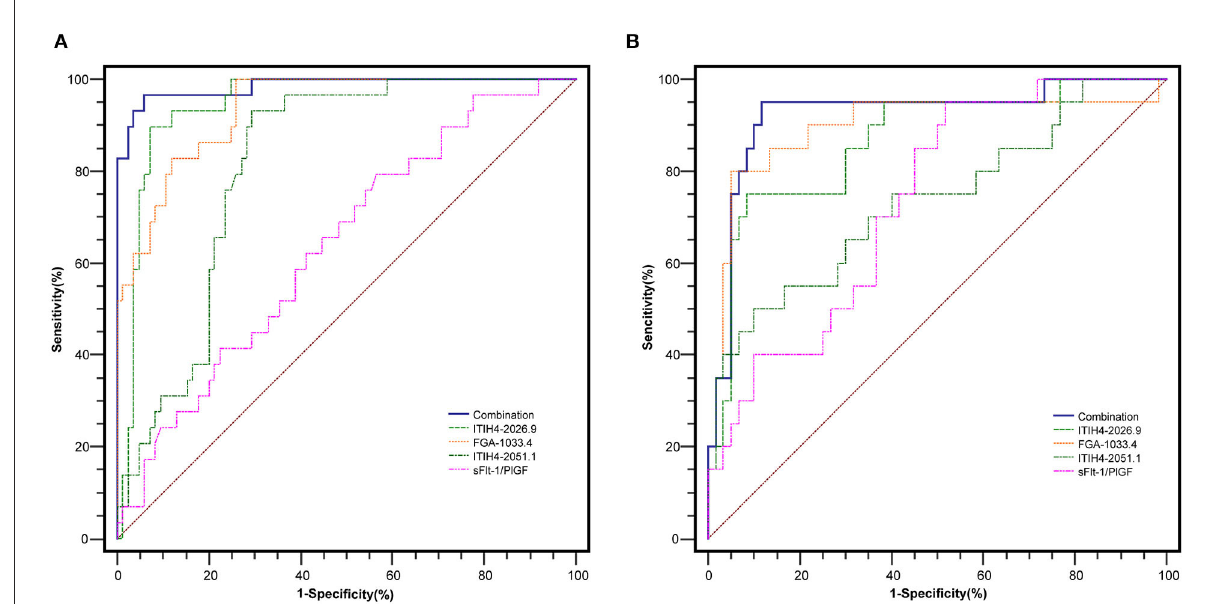
FIGURE3 The ROC analysis of the peptide candidates for PE prediction in the discovery (A) (PE-positive n = 30, PE negative n = 85) and validation (B) (PE-positive n = 20, PE negative n = 60) cohorts.